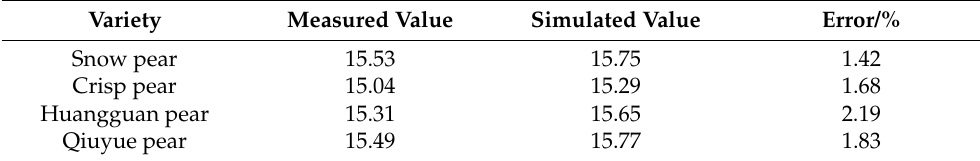
Table 16. Verification of the pear accumulation